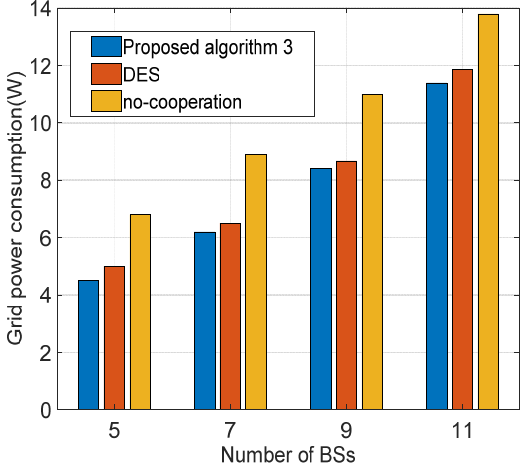
Figure 4. Power consumption versus the number of BSs for different scheme.